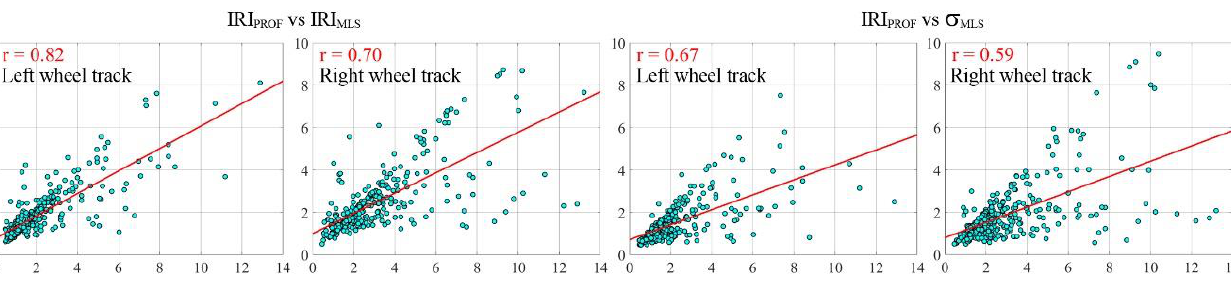
Figure 7. Left wheel track. Comparison between roughness indices: International Roughness Index computed using data by mobile laser scanner (IRI MLS ) and standard deviation of longitudinal roughness (σ) computed using data by mobile laser scanner (σ MLS ) vs. inertial profilometer (IRI PROF ).